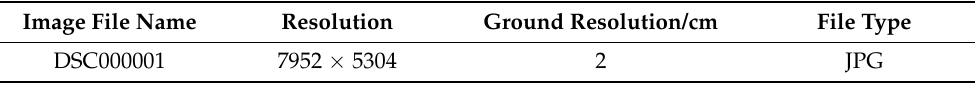
Figure 1. Low-altitude remote sensing images in the village area captured by UAV. Table 1. The metadata of the image. Table 1. The metadata of the